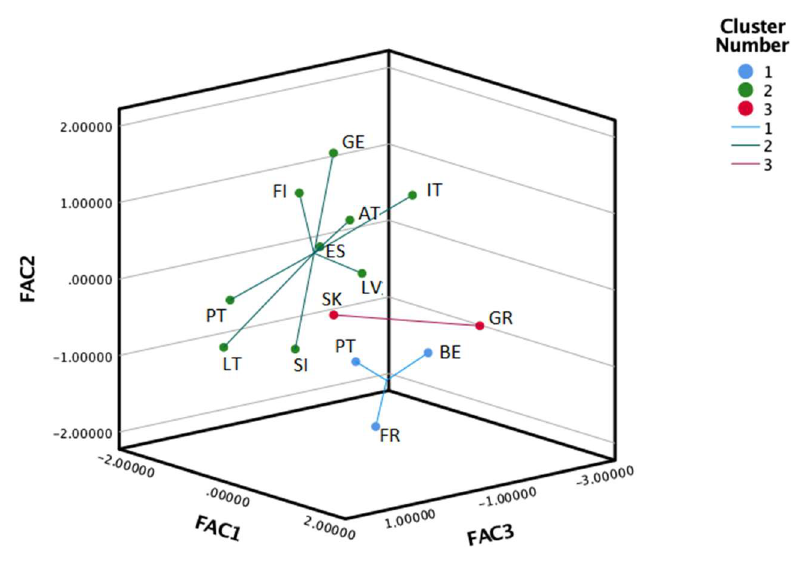
Figure 5. The “truncated” three-cluster case in 2016. Source Authors’ construction.